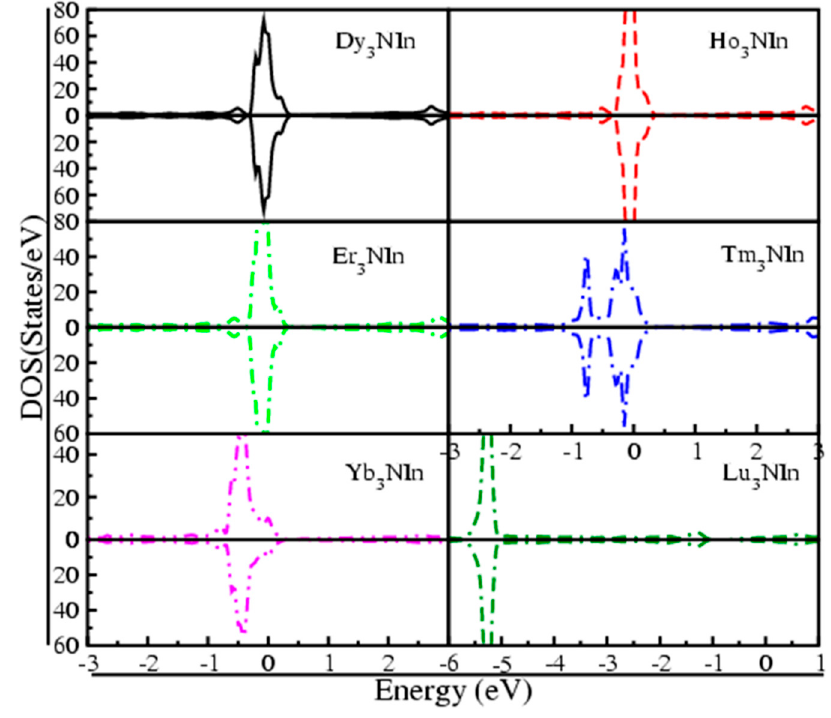
Figure 7. Total DOS of the rare earth nitrides Ln 3 NIn (Ln = Dy-Lu)